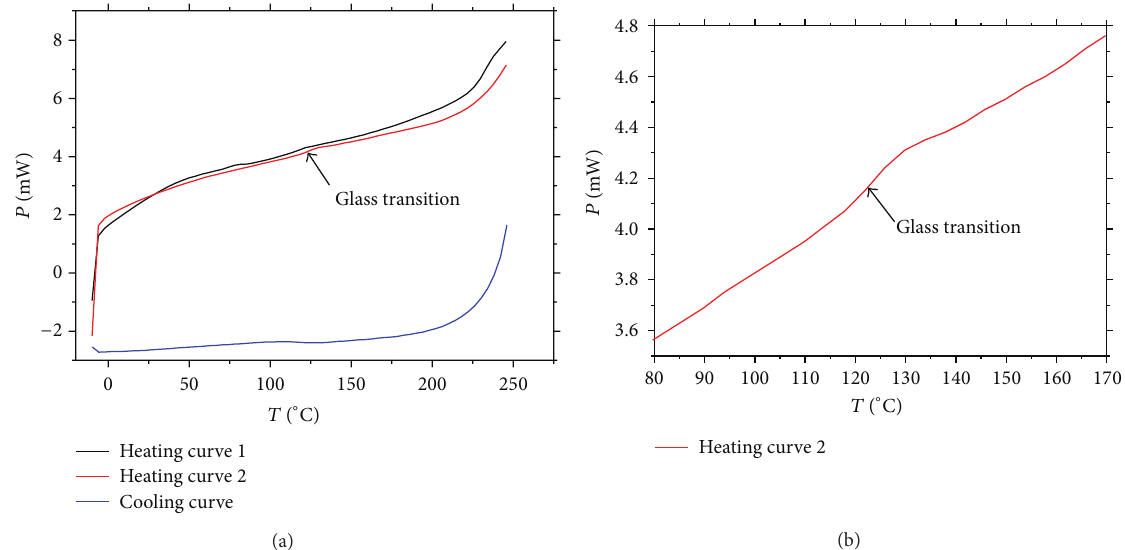
Figure 1: DSC sequential heating and cooling curves for an untreated PMMA/ATH powder (a) as well as a detailed view of the second heating curve (b).